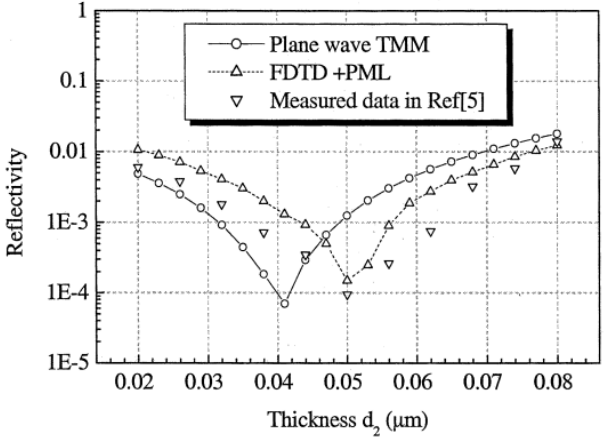
Figure 12. Reflectivity calculated from the finite-difference time-domain (FDTD) and transfer matrix method (TMM) methods compared to experimental data shows that the FDTD method is more accurate than the TMM method. Reprinted with permission from reference [36], Copyright 2003